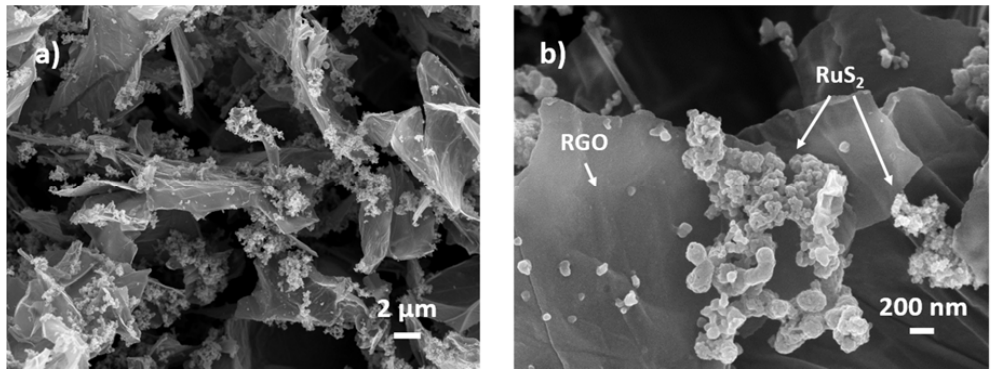
Figure 1. Low-magnification ( a ) and high magnification ( b ) FESEM images of RGO aerogel decorated with Ruthenium active species containing RuS 2 nanostructures.